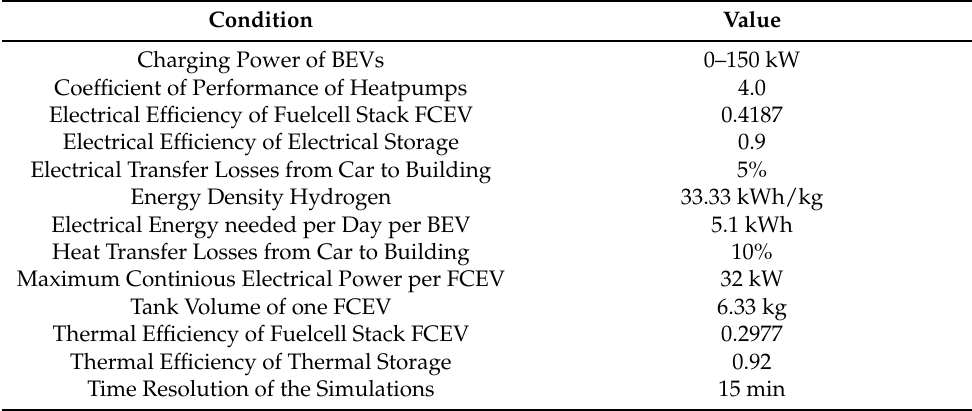
Table A3. Static Boundary Conditions of the